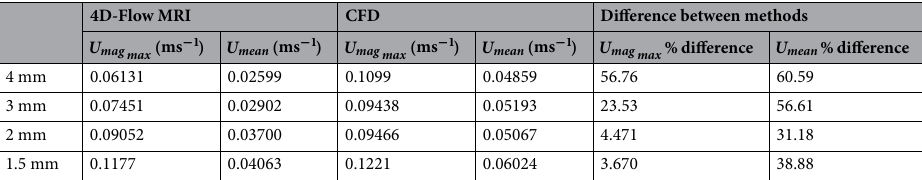
Table 7. Velocity magnitude ( ms − using 4D-Flow MRI data and CFD data, including a comparison between the two methods for each spatial